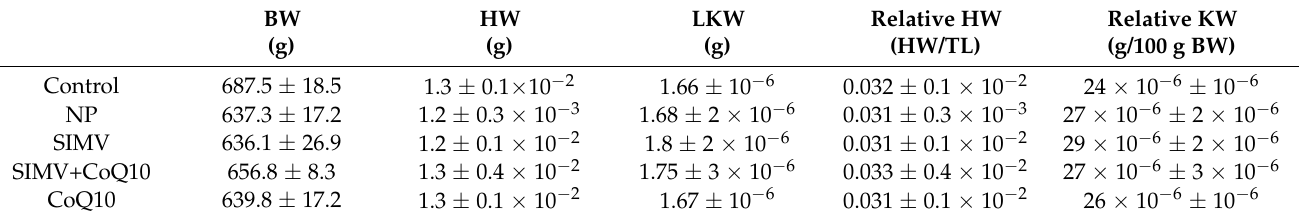
Table 2. Body weight (BW), heart weight (HW), left kidney weight (LKW), relative heart weight as HW/tibia length (TL), and relative KW as KW/BW in the control group and groups treated with empty nanoparticles (NP), simvastatin-loaded nanoparticles (SIMV), a combination of simvastatin- and coenzyme-Q10-loaded nanoparticles (SIMV+CoQ10), and coenzyme-Q10-loaded nanoparticles (CoQ10).